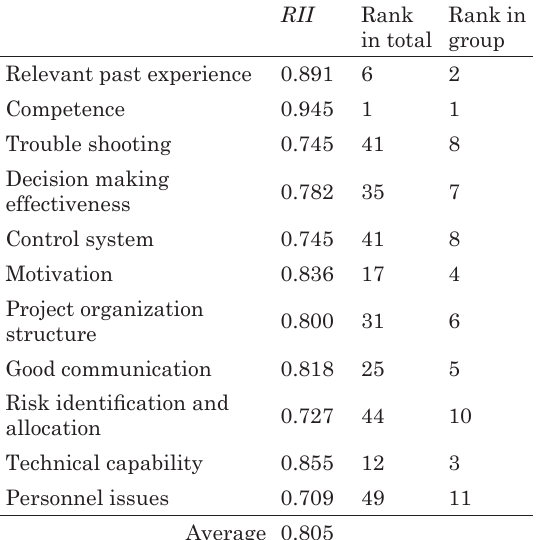
table 4. Summary of survey results on project